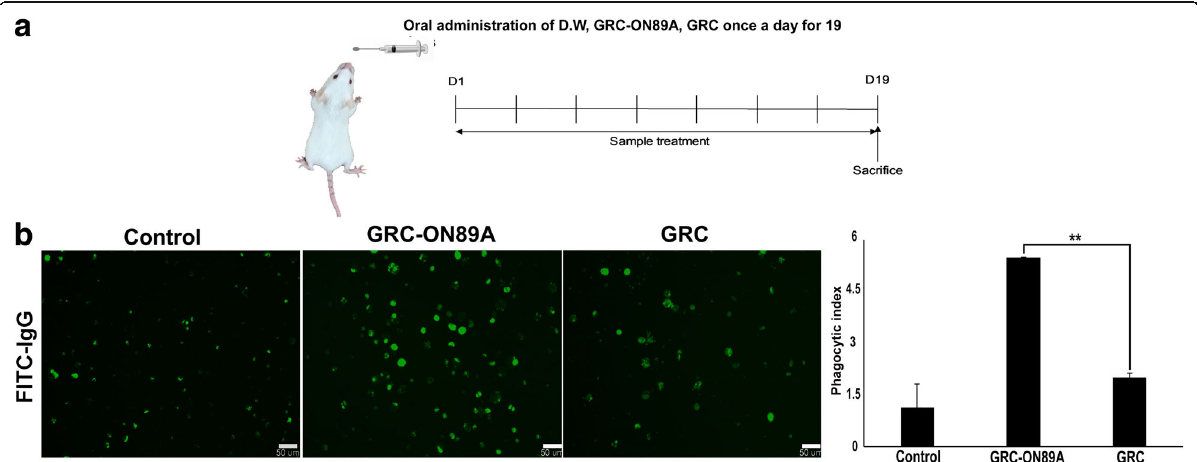
Fig. 4 Effects of GRC-ON89A on the phagocytic activity of peritoneal macrophages in normal mice. a Scheme summarizing the normal murine model protocol. b Fluorescent microscopy images (left panel) of phagocytosis of primary peritoneal macrophages from CY-treated immunosuppressed model group after oral administration (D.W., 1% GRC and 1% GRC-ON89A). Quantification of fluorescent bead uptake by primary peritoneal macrophages from CY-treated immunosuppressed groups exposure to fluorescent beads for 48 h (right panel). The phagocytic index was quantified for statistics analysis using Image J software. One-way ANOVA was used for comparison of group means, followed by Dunnett ’ s t -test (**= p <0.01 vs GRC). Each figure is representative of three independent experiments; Scale bars =50 μ